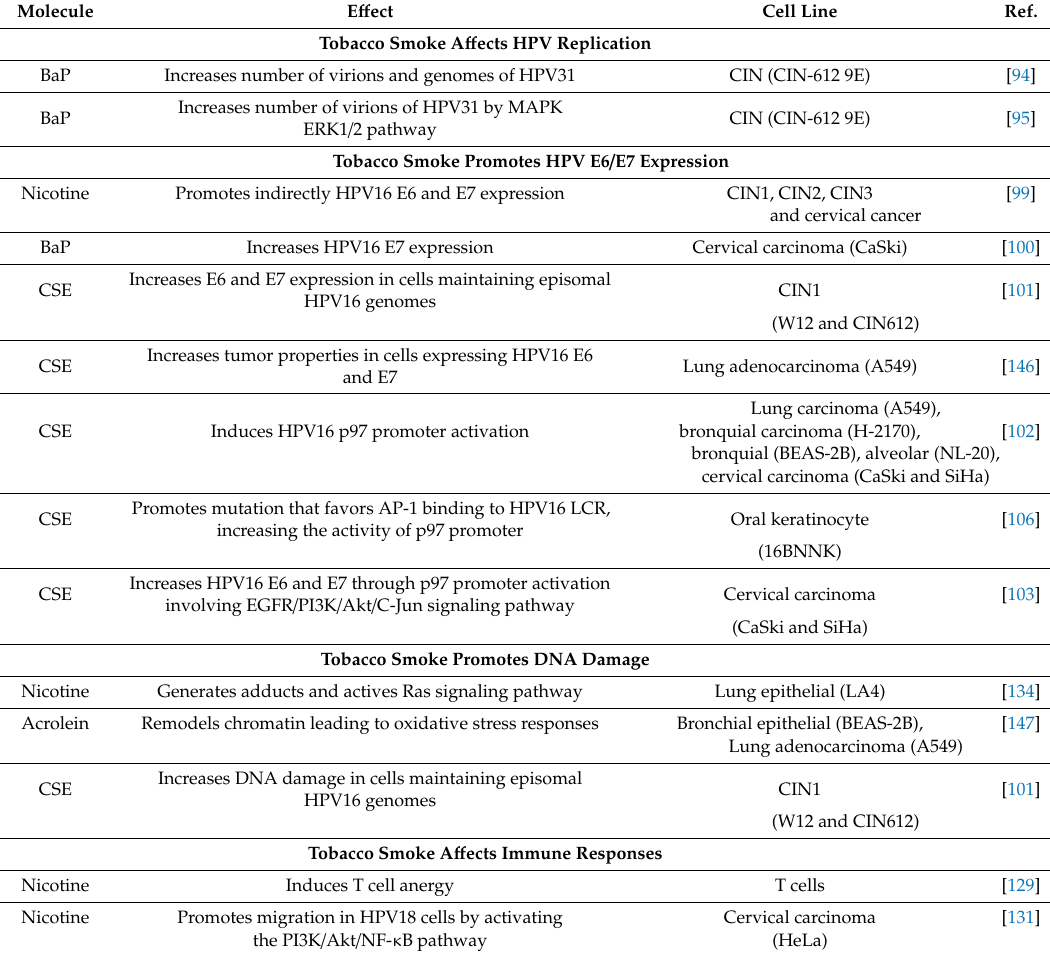
Table 1. Tobacco smoke promotes viral and host-related changes involved in epithelial carcinogenesis 1 . Molecule E ff ect Cell Line